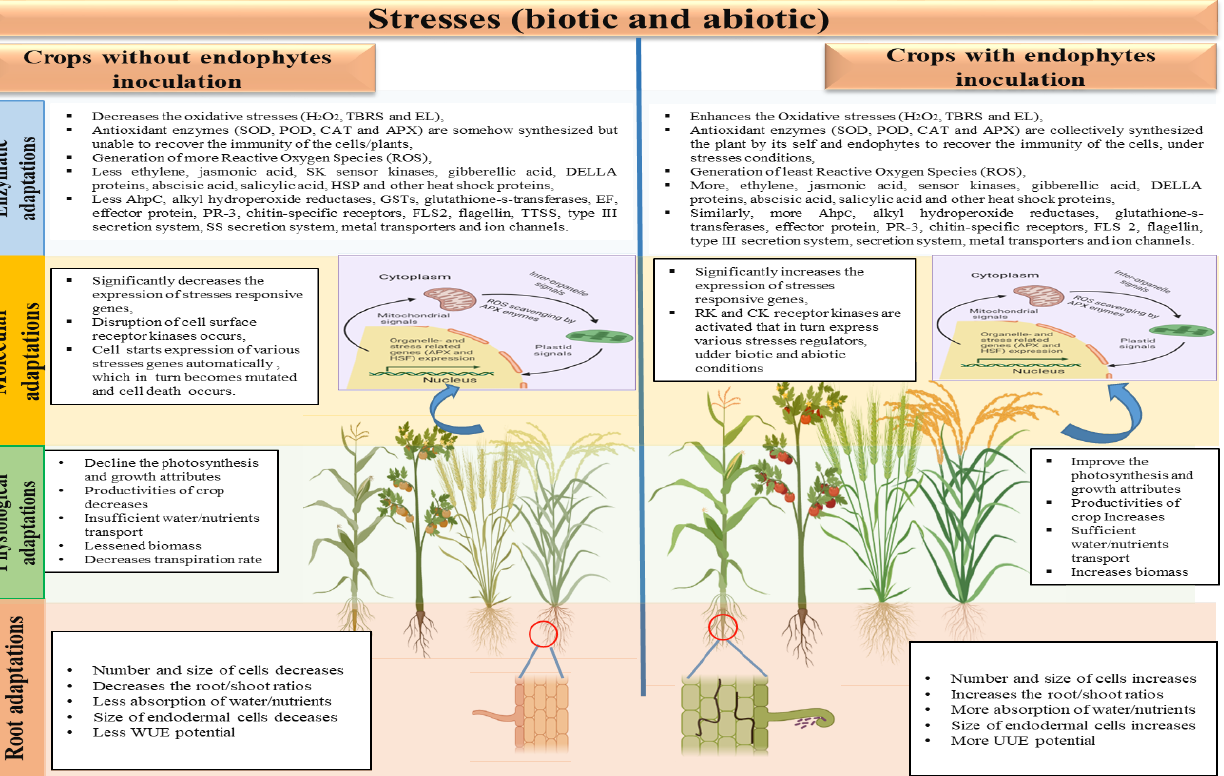
Figure 3. A schematic diagram with comparison of crops with and without inoculation of endophytes under different stressed conditions. Crops exposed to any type of stressed condition reduces roots to shoots length and other physiological and molecular patterns, while the endophytes improve such traits by triggering their antioxidant enzymes and other genetic pathways.